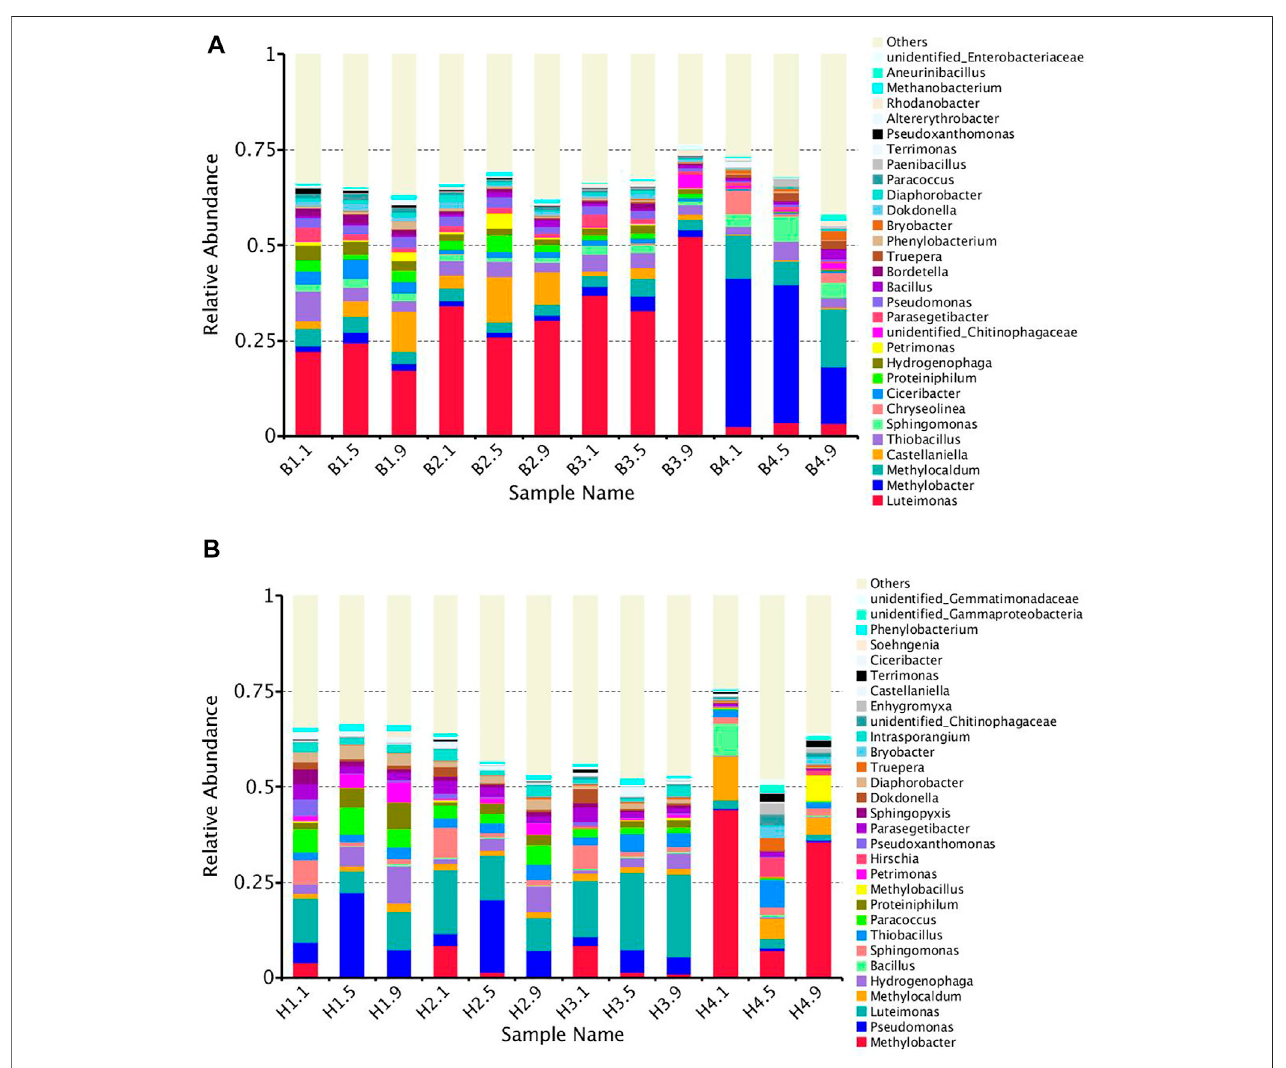
FIGURE 4 | Histogram of species relative abundance at the genus level of CB (A) and CH (B) .